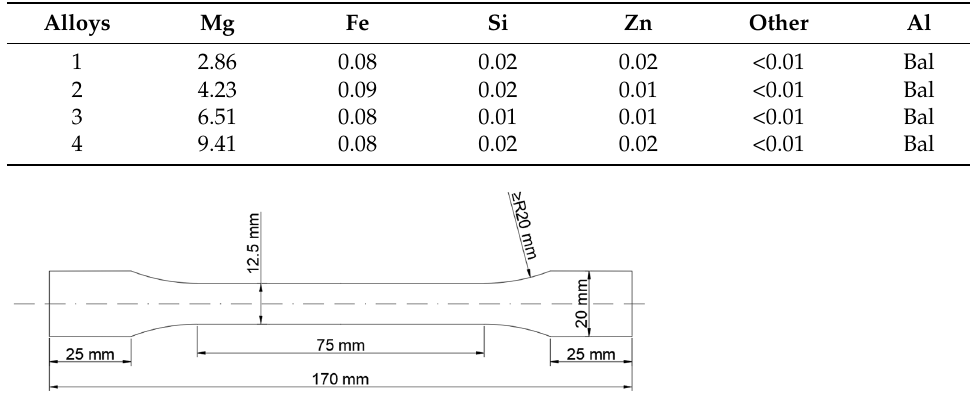
Figure 1. Dimensions of the 1.5-mm-thick tensile specimens.